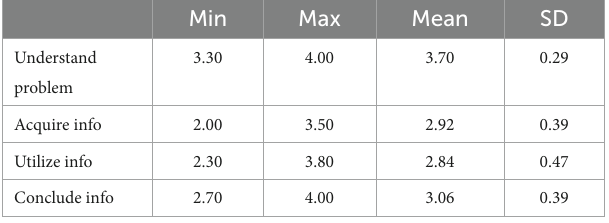
TABLE 2 Critical thinking post-test mean and SD.